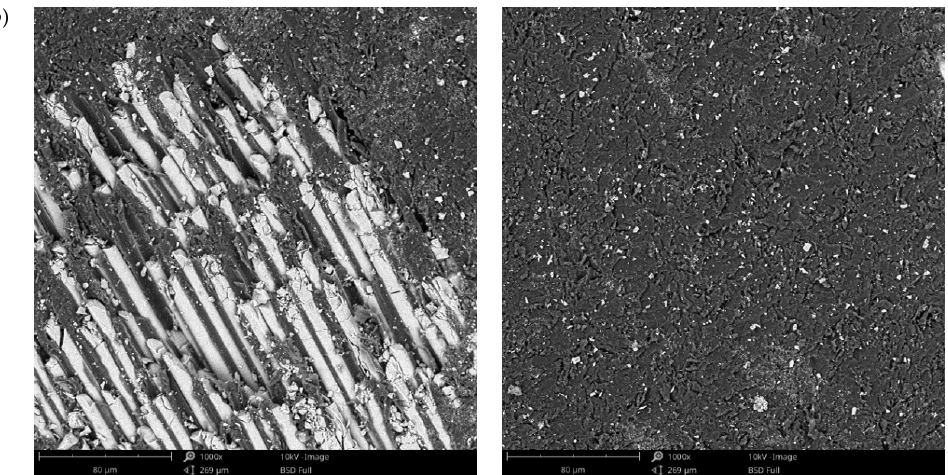
Figure 9. SEM images of the C2 sample surface after immersion tests at ( a ) 3 days and ( b ) 21 days in artificial saliva with